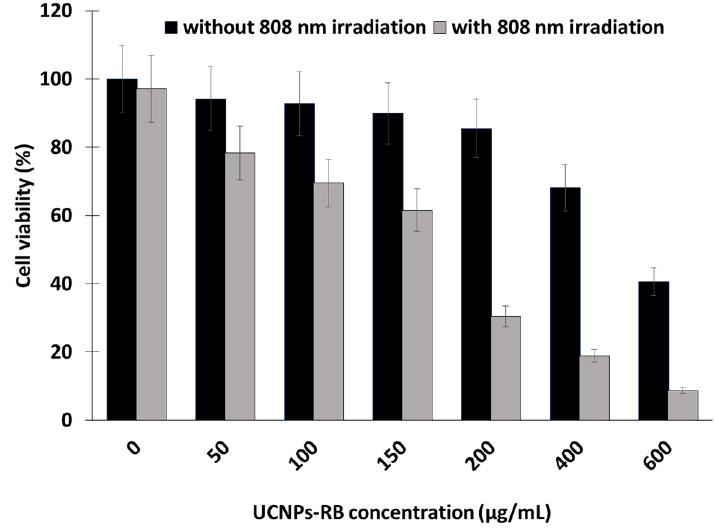
Figure 4. HeLa cell viability when treated with different concentrations of UCNPs-RB with and without irradiation (808 nm, 0.67 W/cm 2 , 10 min). Adapted from Wang et al. [23].